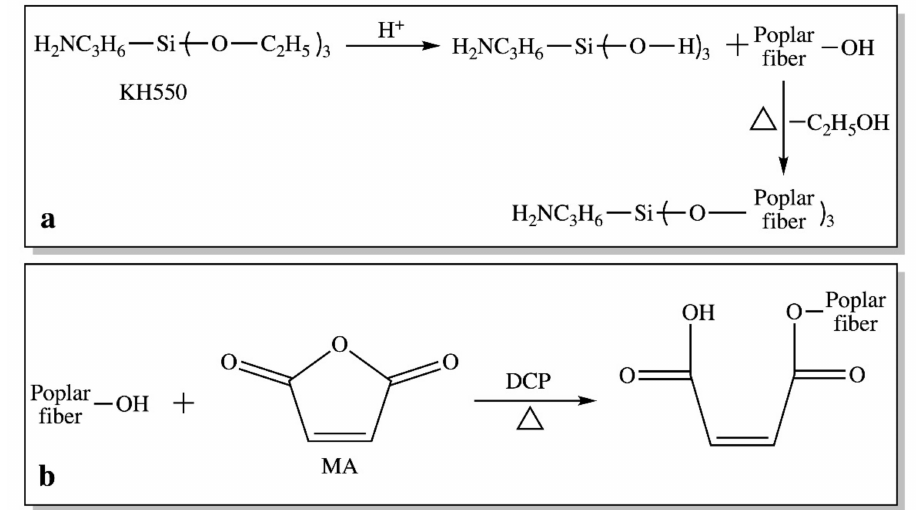
Figure 1. The poplar fiber modification scheme with a silane coupling agent (KH550) ( a ) and maleic anhydride (MA) ( b